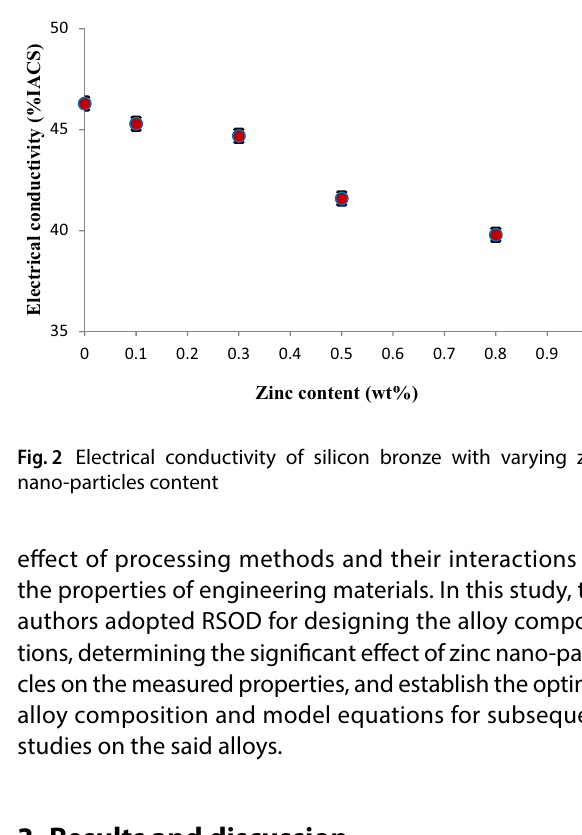
Fig. 1 Hardness of silicon bronze with varying zinc nano-particles content